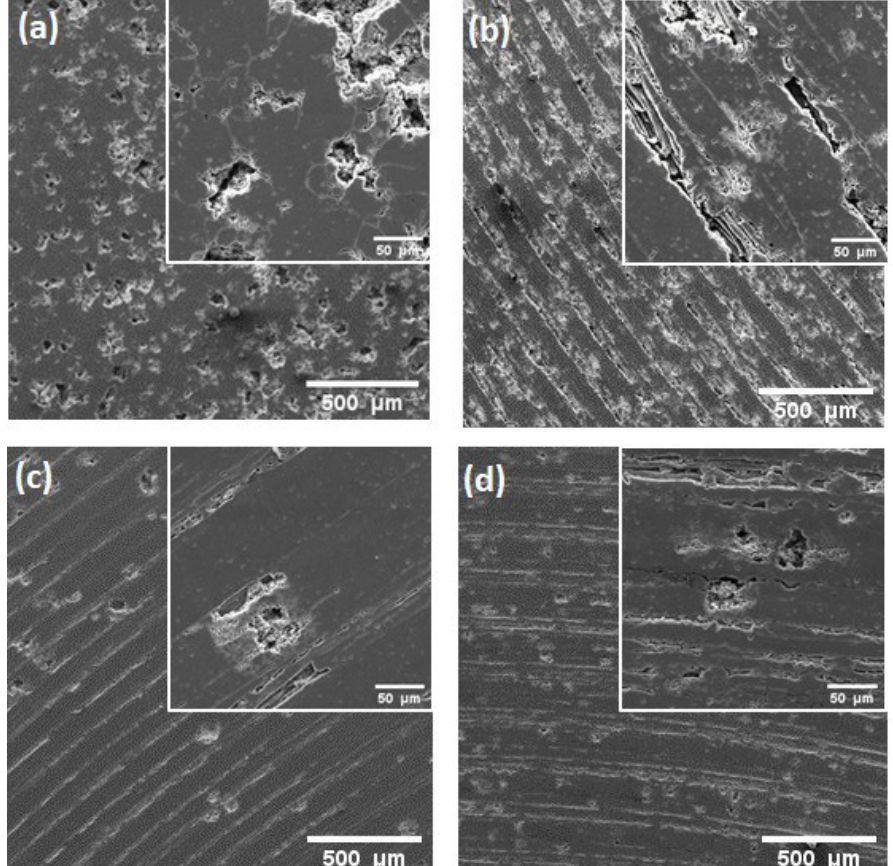
Figure 9. SEM micrographs of the surface of the AA6005 after potentiodymic polarization test under 3.5% NaCl solution to (a) BM and for welded joints at rotational speeds of (b) 1,000 rpm (c) 1,500 rpm and (d) 2,000